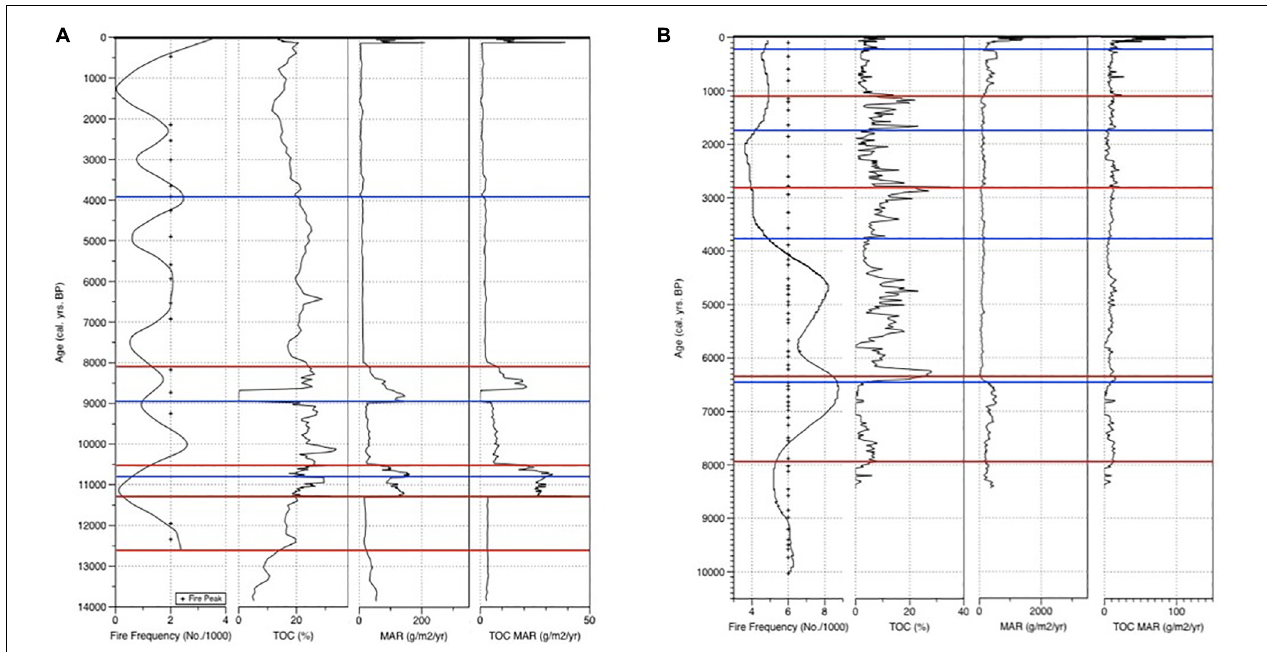
FIGURE 4 | TOC MAR, MAR, TOC, inferred fire frequency, and fire peaks of Marion (A) and Dog Lake (B) . Blue lines represent core breaks. Red lines represent tie points. Dog Lake charcoal data is interpolated from Hallett and Walker (2000).